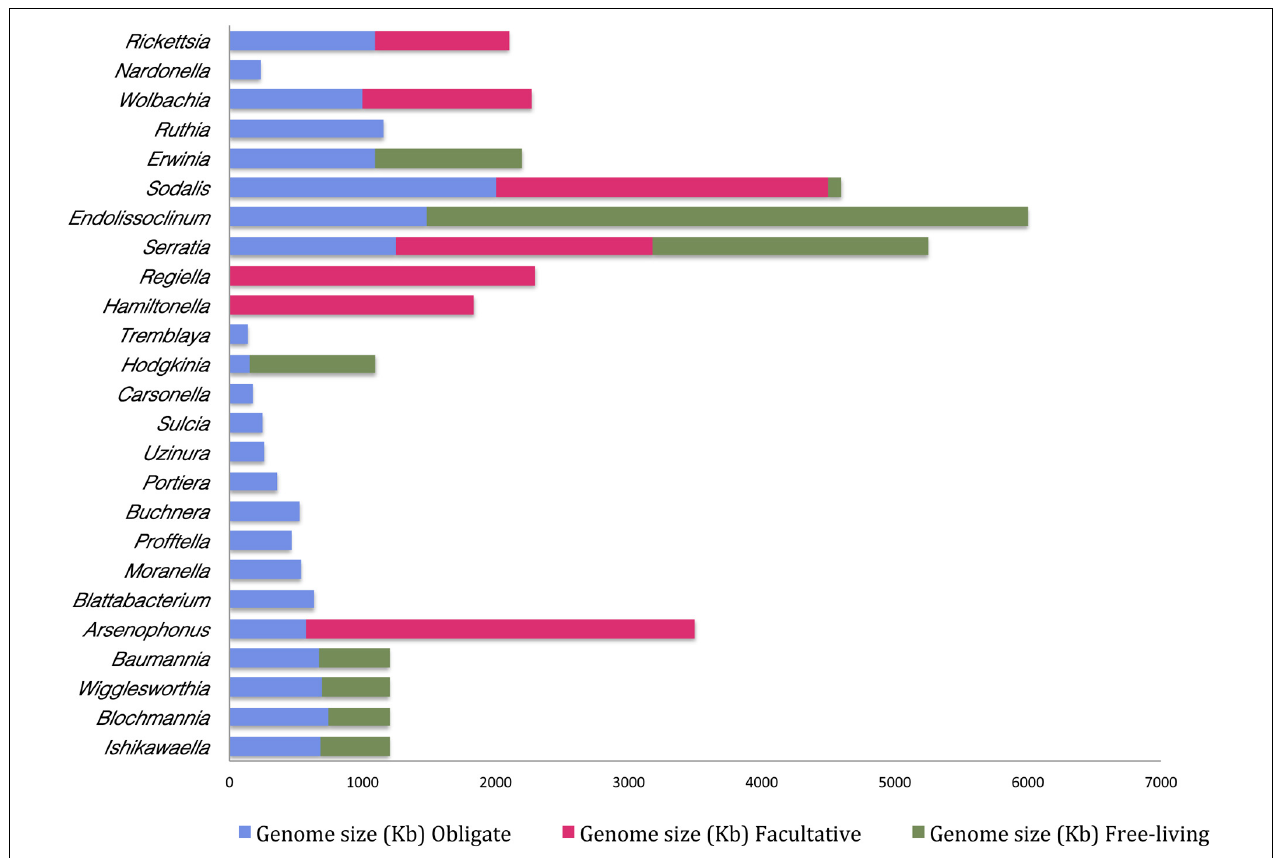
FIGURE 2 | Differences in genome sizes of the free-living bacteria and their cognates in a facultative or obligate symbiotic relationship with an insect host. Names on the Y -axis are the bacterial species and genome sizes (Kb) are indicated on the X -axis. (This figure is based on published information and the relevant references are provided in Supplementary Table T1